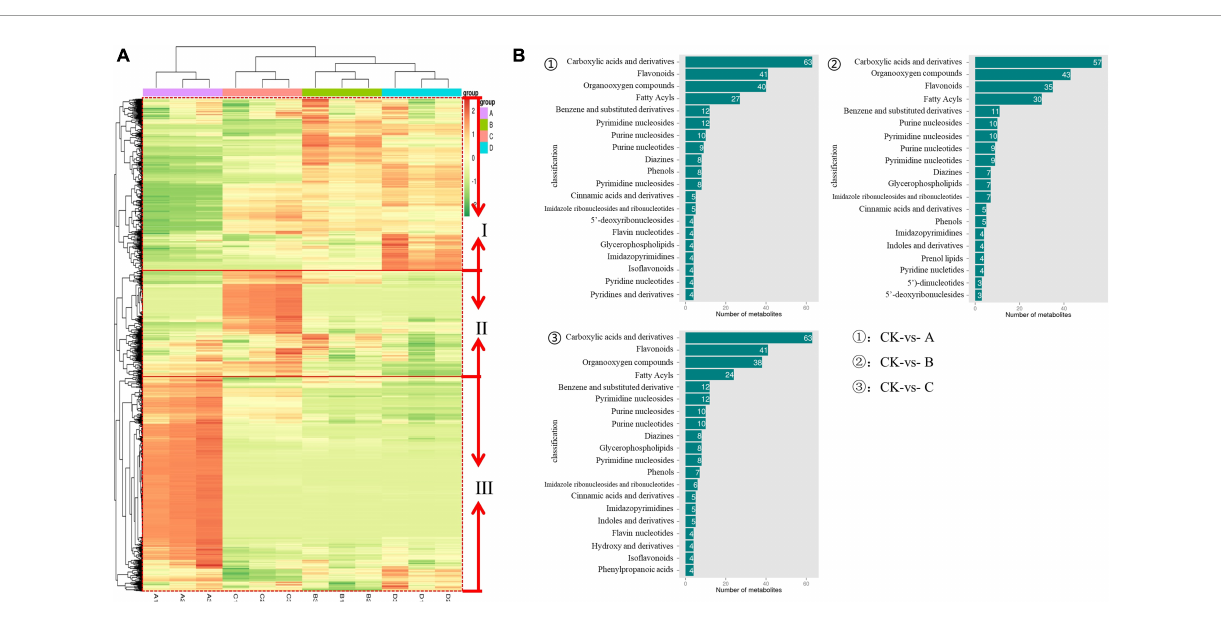
FIGURE3 The metabolomics data were subjected to heatmap analysis (A) and column diagram differential metabolites (B) in IDTs. In the heatmap, a color-coded scale grading from orange to green represented the metabolites from high to low. The different fermentation treatments of instant dark tea were